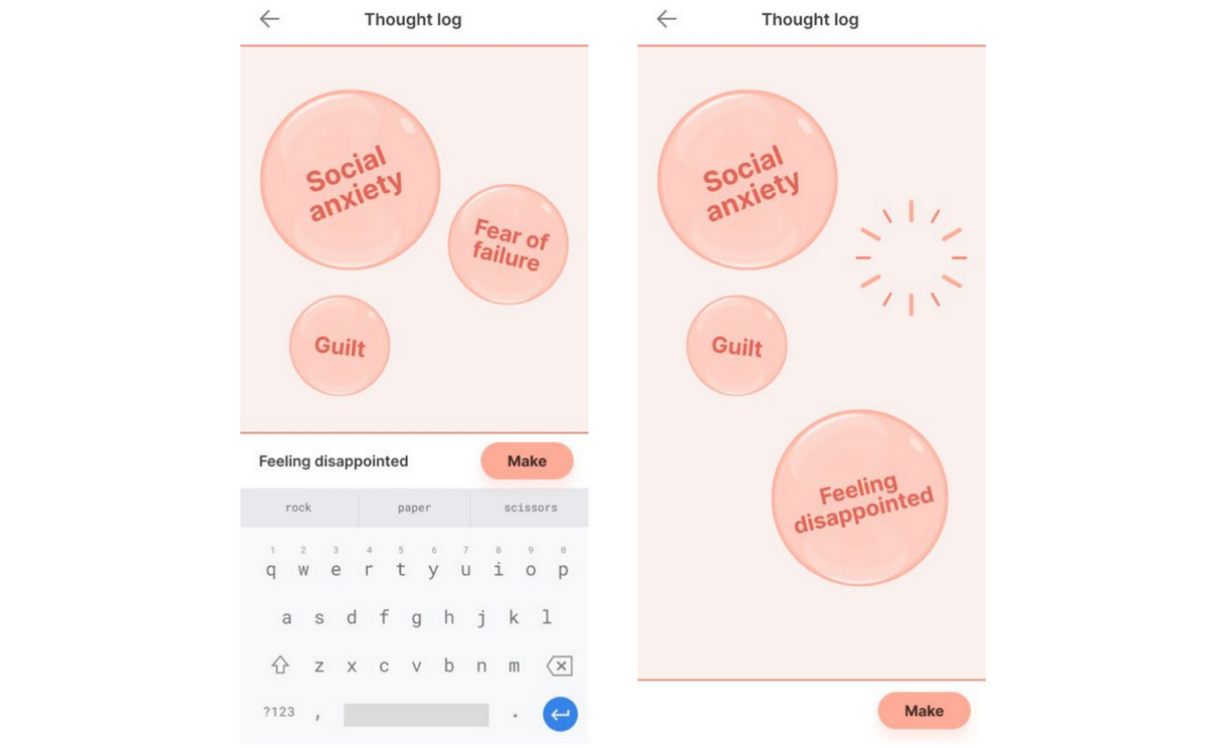
Figure 7. The thought log allows participants to label and track thought patterns in real